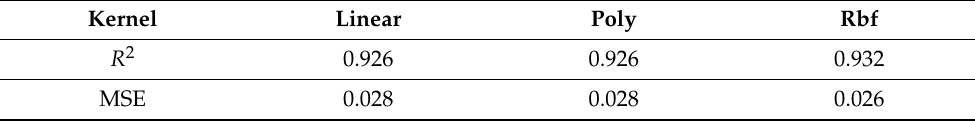
Table 2. Model effects under different kernel functions.